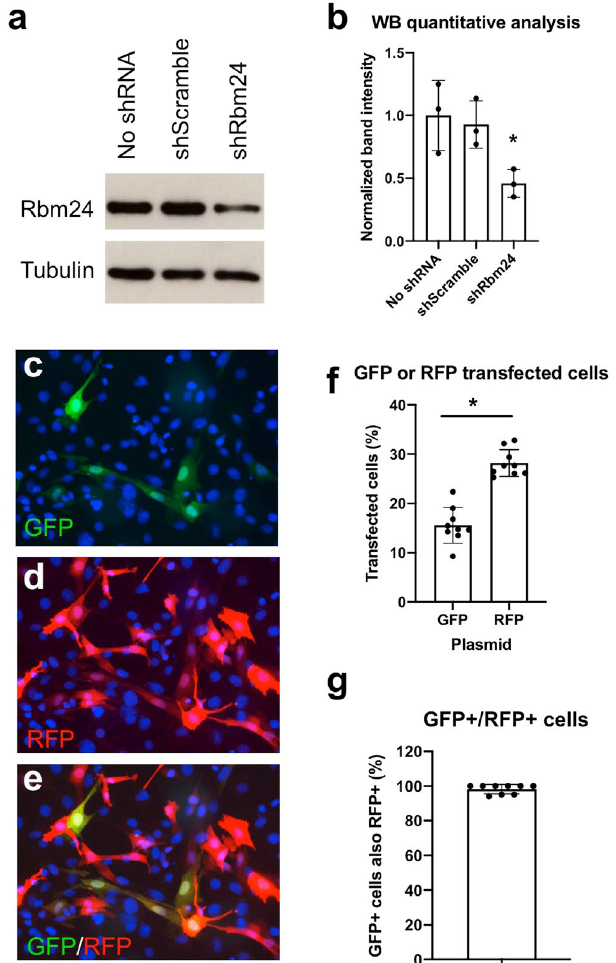
Figure 4. Experimental set-up for the analysis of Rbm24 functions in muscle regeneration. ( a ) Western blot analysis of Rbm24 protein levels in isolated satellite cells from indicated conditions. Tubulin served as a loading control. Full-length blots are presented in Supplementary Fig. S3. ( b ) Quantification of western blot results followed by ANOVA analysis shows the significant effect of Rbm24 knockdown. Rbm24 protein level in untransfected satellite cells is set to 1 as a reference, after normalization to tubulin. Data are the mean ± s.e.m. from three independent experiments. ANOVA F (df 2.6) = 6.182, p < 0.05; * p < 0.05 by Tukey’s HSD test. ( c – e ) Co-transfection of pEGFP-N1 and pCS2-RFP plasmids mixed at a 1:10 ratio. DAPI was used to stain nuclei. Note that all GFP-positive cells also expressed RFP. From this result, it can be extrapolated that, when pEGFP-N1 and shScramble or shRbm24 plasmids are used at the same ratio, GFP-labeled cells along with a proportion of unlabeled cells should be targeted by shRbm24. ( f ) Quantification of GFP-positive or RFP- positive cells. Data are the mean ± s.e.m. from three independent experiments. * p < 0.05 by Tukey’s HSD test. ( g ) Quantification of the overlapping expression of GFP with RFP in transfected satellite cells. Data are the mean ± s.e.m. from three independent